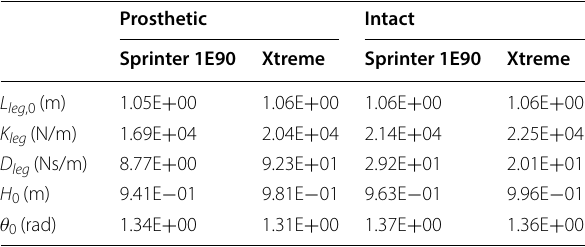
Table 1 Parameters for the RSPs and intact leg in the SLIP